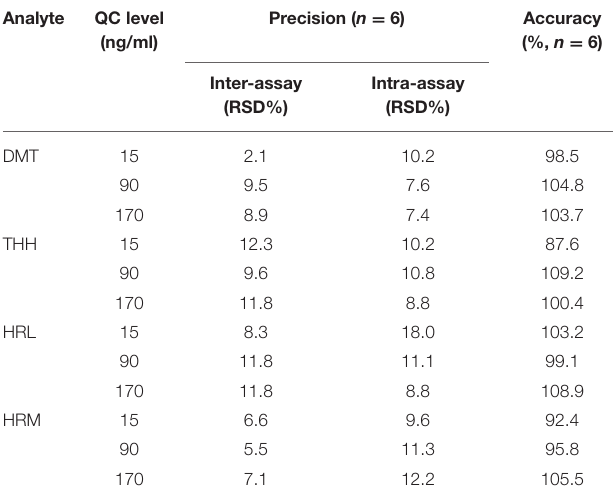
TABLE 5 | Inter-assay and intra-assay precision and accuracy for dimethyltryptamine (DMT), harmine (HRM), harmaline (HRL), and tetrahydroharmine (THH) in fortified urine samples.